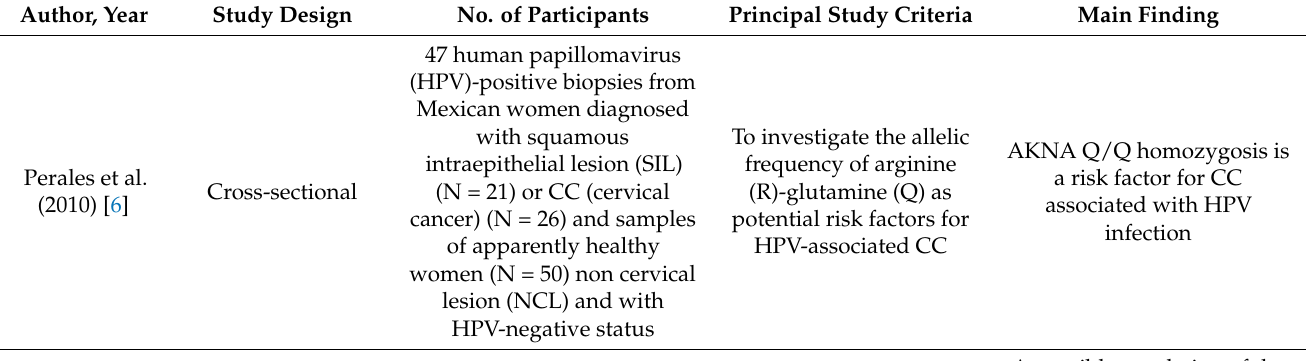
Table 5. Characteristics of the selected observational studies selected for the scoping